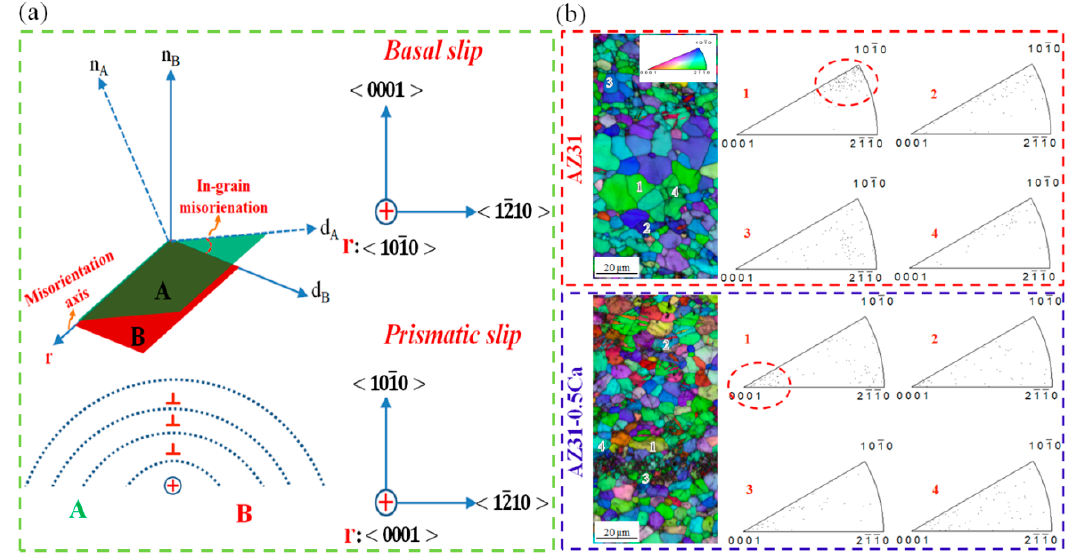
Figure 8. ( a ) Schematics showing the main concept of the relation between the in-grain misorientation axis and the activated slip system; ( b ) ND inverse pole figure maps and related in-grain misorientation axis analysis taken for four randomly-selected grains from the AZ31 and AZ31-0.5Ca alloys. The two examples indicated by the dashed circles (grains 1 in the AZ31 and AZ31-0.5Ca alloys) show the shifting of the misorientation axis toward <0001> in the AZ31-0.5Ca and toward < 21(cid:3364)1(cid:3364)0 > – < 101(cid:3364)0 > in AZ31.